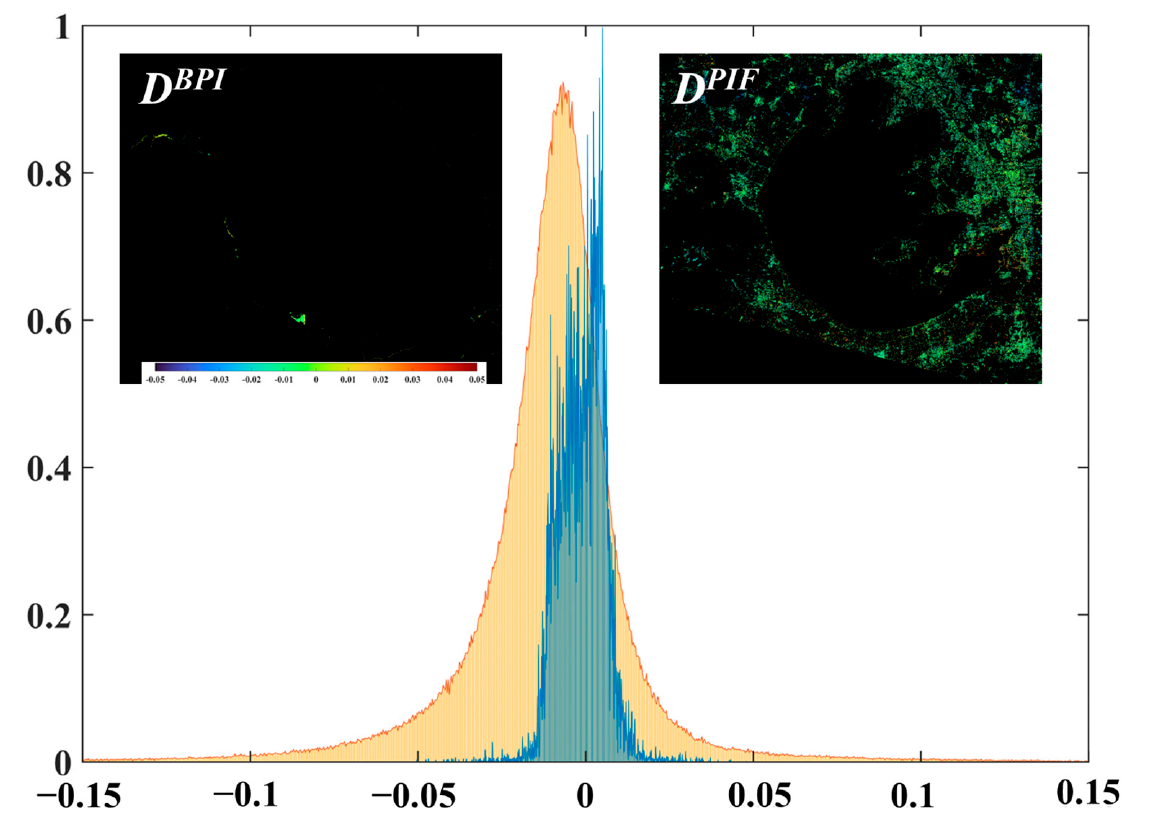
Figure 6. Histogram of D BPI (blue bar) and D PIF (yellow bar) derived by two date images (Dates: 11 May 2017 and 27 May 2017) in Lake Taihu, China.